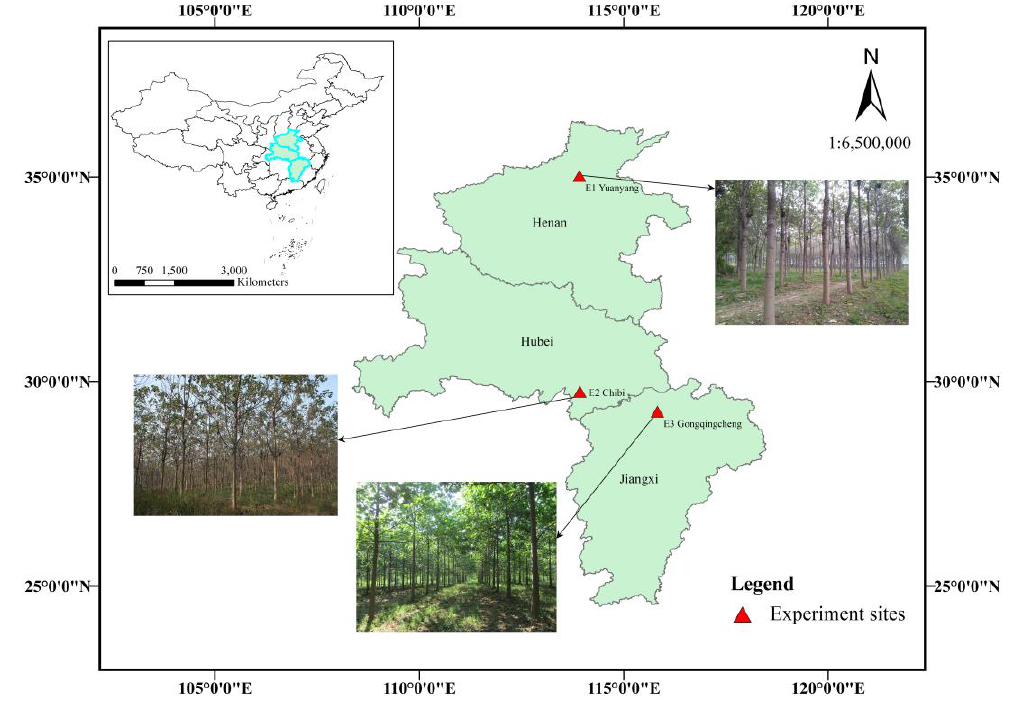
Figure 1. Geographical locations of the three test sites.